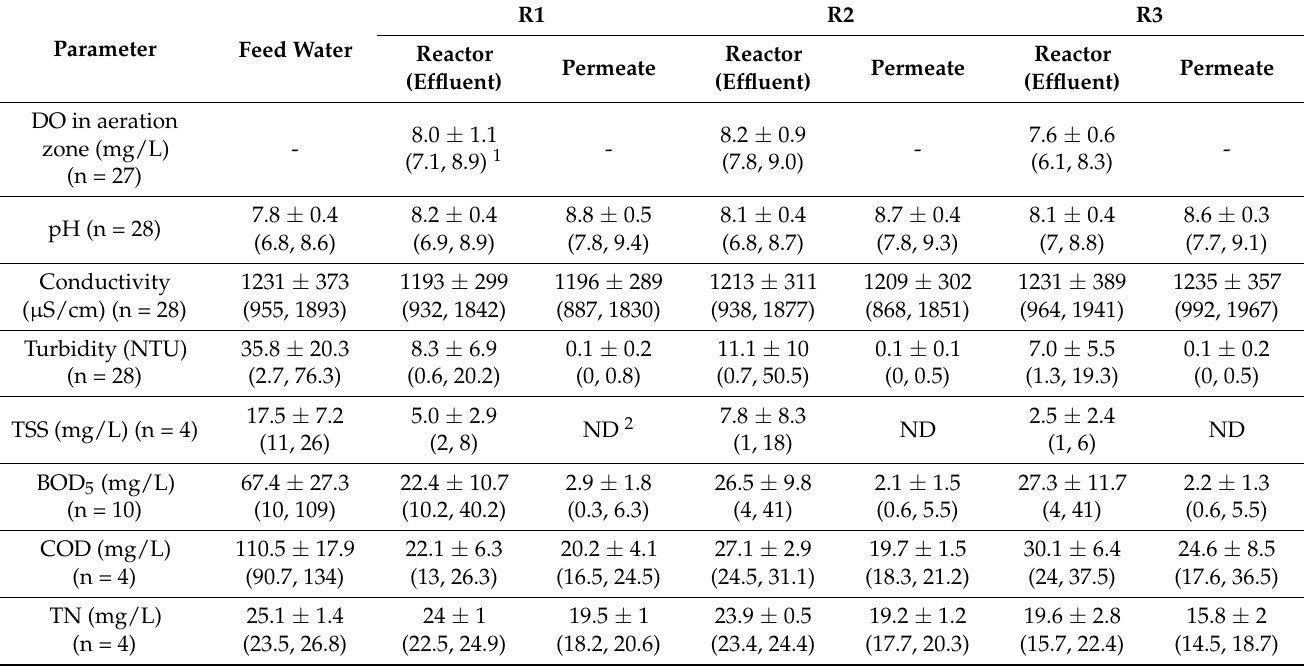
Table 3. Water quality in the feed, effluent, and